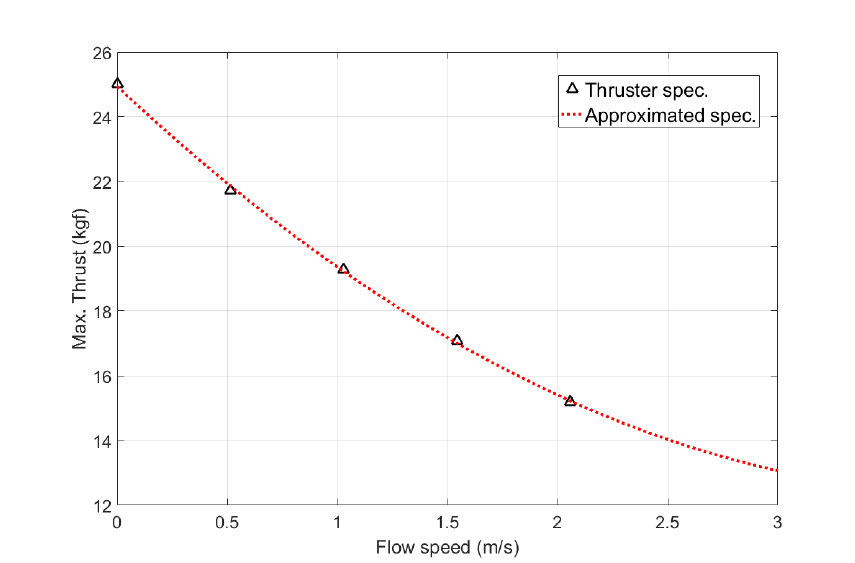
Figure 5. Horizontal thruster’s specification: maximum thrust force vs. flow